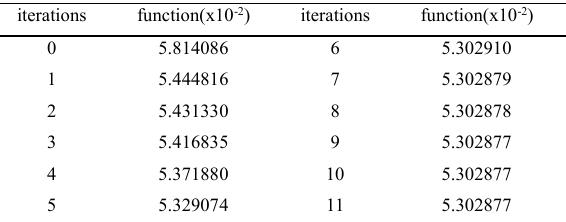
Table 2: the process of the optimization